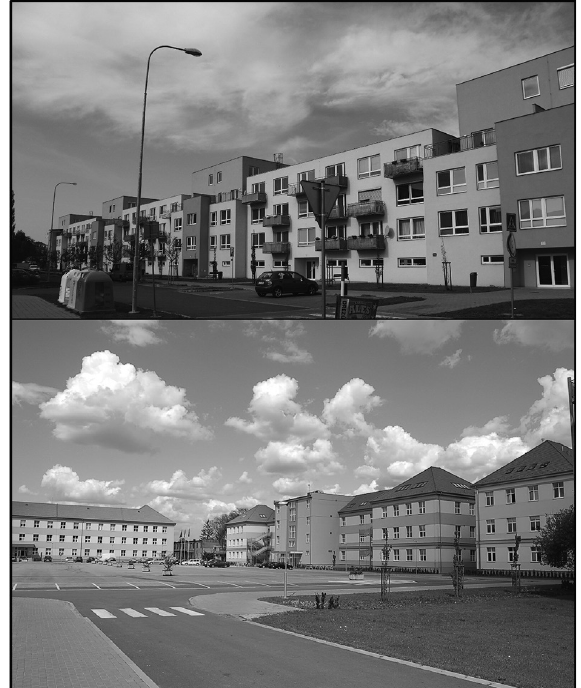
Fig. 5. Top: New residential complex in the post-military area in Uherské Hradiště (photo: Hercik 2012) Bottom: Revitalised buildings in the post-military area in Uherské Hradiště (photo: Hercik